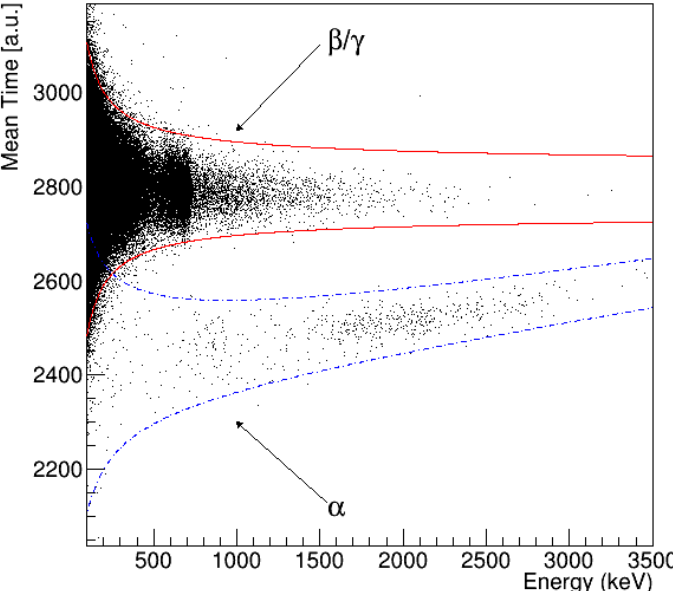
Figure 2. Mean time versus Energy scatter plot for the data collected in low-background measure- ments with the 7 g CHC scintillating crystal over 2848 h [7]. The mean time values corresponding to for alphas or betas/gammas events, along with intervals containing 99% events of each type are shown.